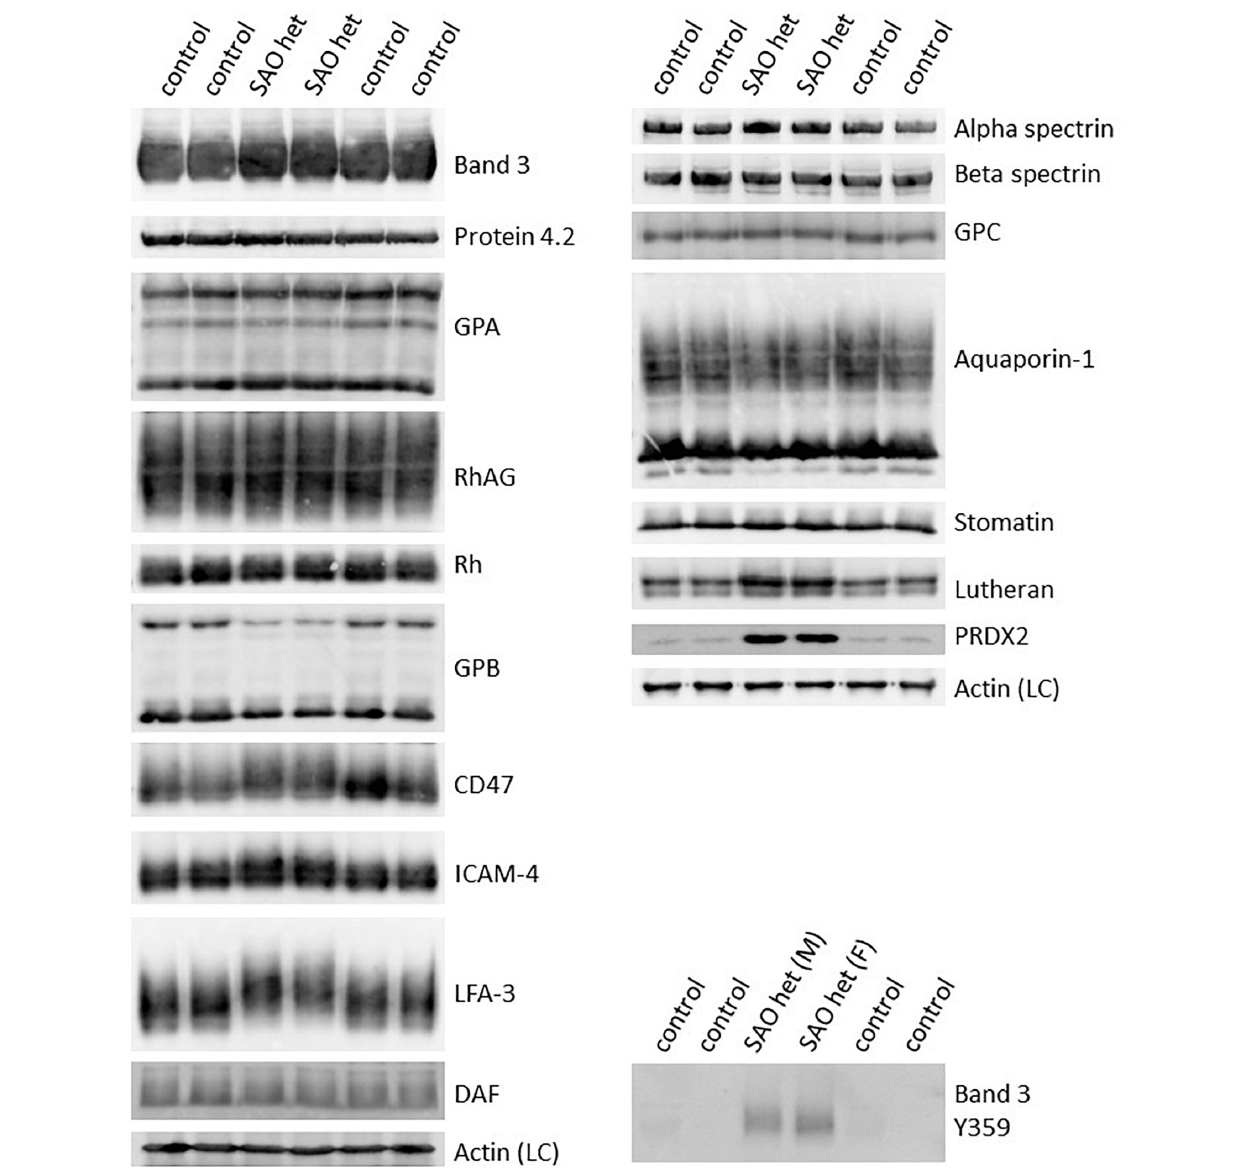
FIGURE 2 | Altered expression of membrane proteins in heterozygous SAO red cells. Red cell membranes from SAO and control peripheral blood samples were prepared, separated by SDS-PAGE and immunoblotted. The antibodies directed against protein 4.2, GPA, RhAG, Rh polypeptides, CD47, aquaporin-1, GPC, stomatin and phospho-Tyr359 band 3 were in-house rabbit polyclonal antibodies. Commercial antibodies were used to detect actin (ab6276) and peroxiredoxin-2 (PRDX2; ab109367) both from Abcam, Cambridge, United Kingdom. Monoclonal antibodies were used to detect band 3 (BRIC170), alpha-spectrin (BRIC174), beta-spectrin (BRAC65), GPB (and to a lesser extent GPA, R1.3), ICAM-4 (BS46/BS56), LFA-3 (BRIC5), DAF (BRIC128) and Lutheran (BRIC221). SAO het and SAO het (F): Membranes prepared from the heterozygous father of the homozygous SAO child. SAO het (M): Membranes prepared from the heterozygous mother of the homozygous SAO child. LC, Loading